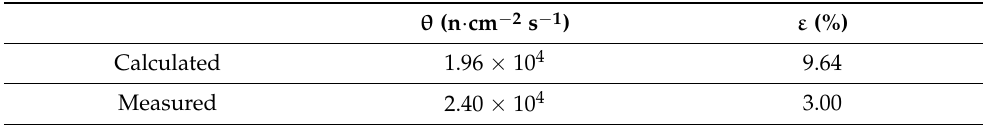
Table 2. Comparison of simulated and measured epithermal neutron fluence rate θ per unit lethargy and their respective relative uncertainties ε .